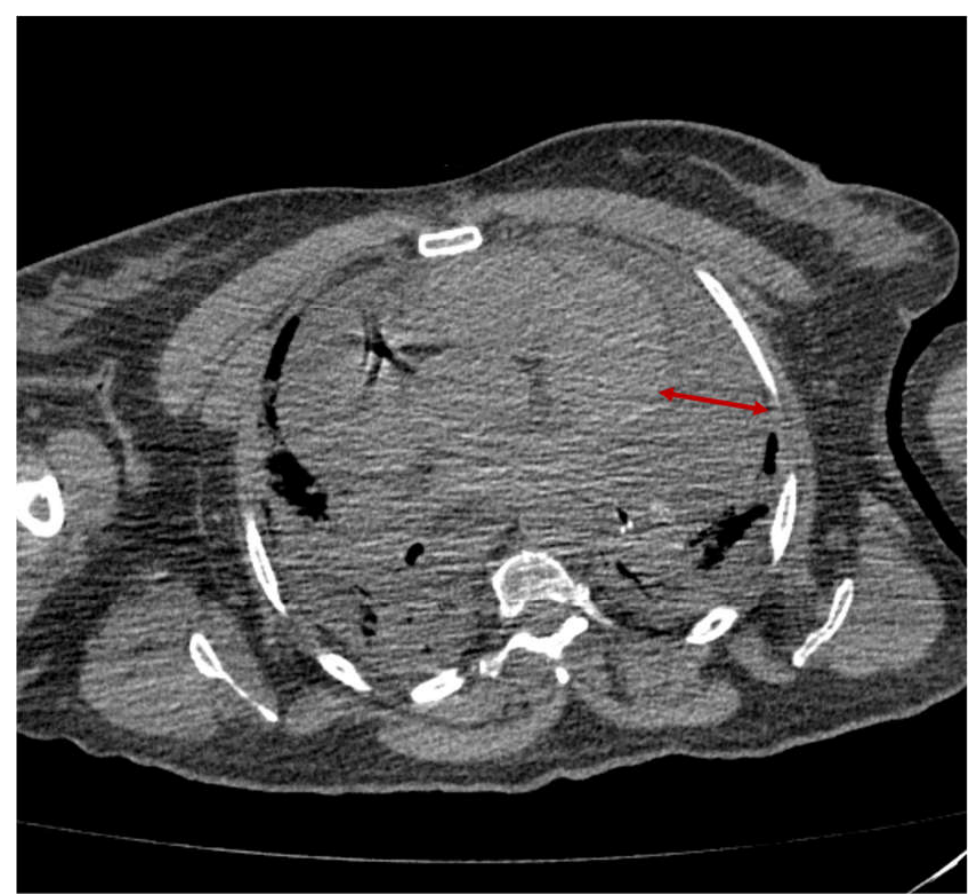
Figure 3. Thoracic CT-scan showing circumferential pericardial fluid ( Case 3